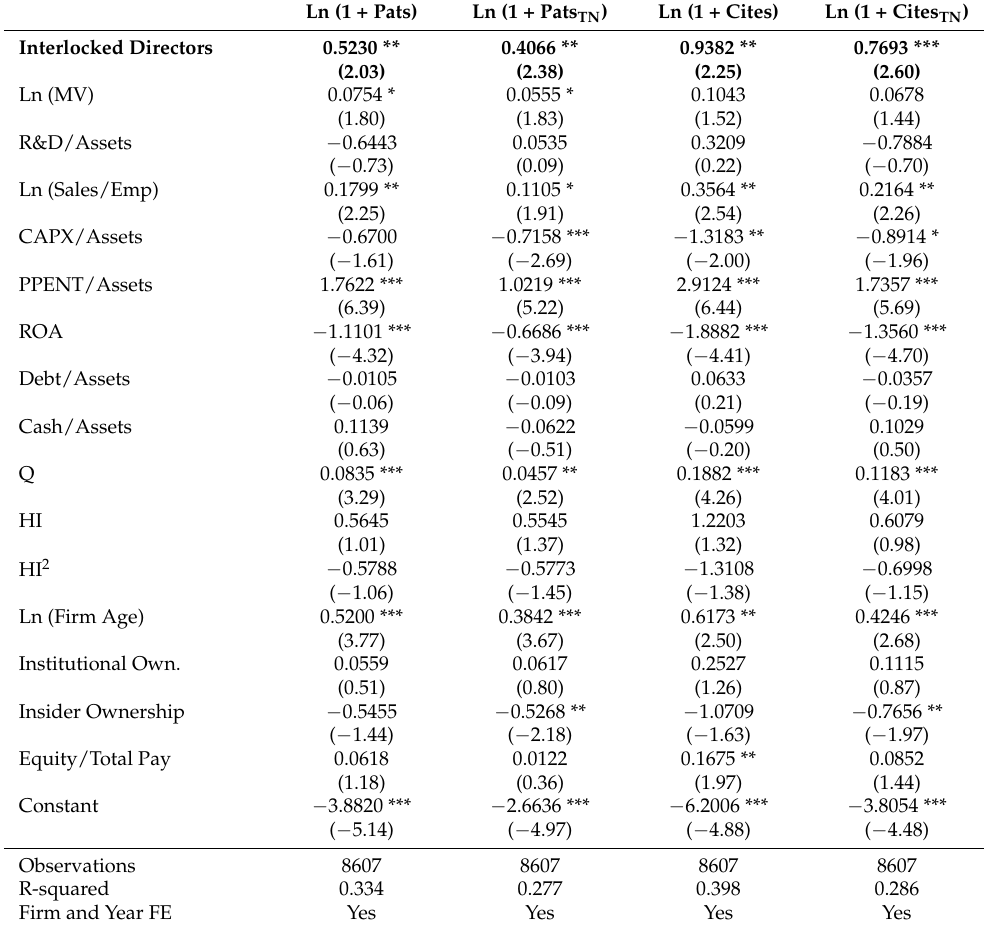
Table 4. Regressions of Innovation on Director Interlocks. This table presents regression results of Innovation on Interlocked Directors, defined as the percentage of directors with any interlocking relationship with another board. All regressions contain firm and year fixed effects. All except binary variables are winsorized at the upper and lower 1% levels. Full variable definitions are provided in the Appendix A. T-statistics are reported in parentheses. Standard errors are adjusted based on the Huber–White sandwich estimate of variances and are clustered by firm. *** indicates significance at the 1% level, ** 5% and *